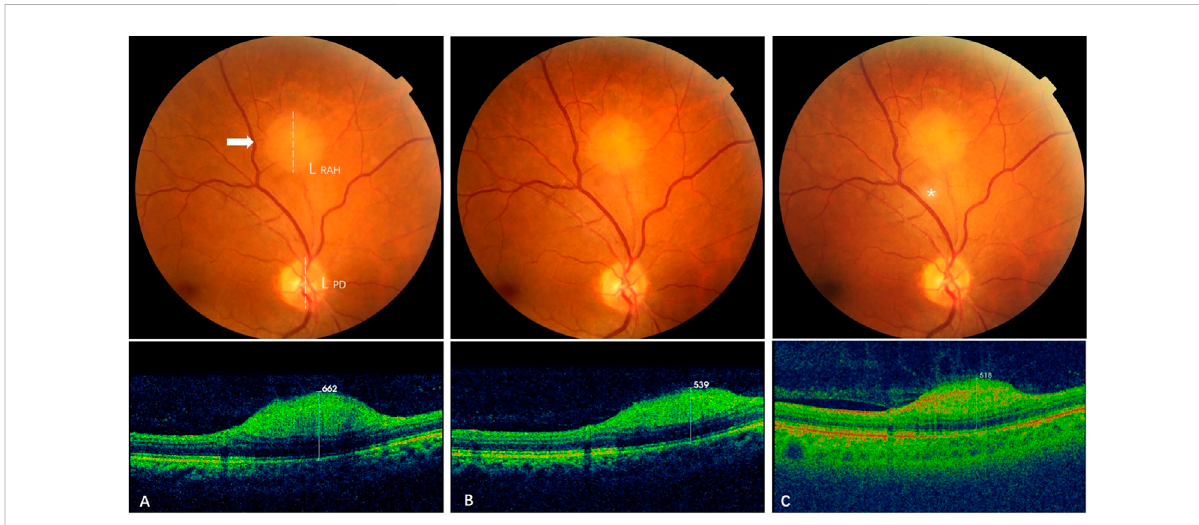
FIGURE 3 Effectofsirolimusontype1retinalastrocytichamartomaovertime. (A) Atbaseline,agray-whitetype1RAHlesion(arrow)located2DDsuperior to the optic disc of the right eye was measured with a maximal thickness (MT) of 662 μ m by spectral-domain optical coherence tomography (SD- OCT)andalongestbasediameter (LBD)of1.27DDbycalculatingtheratio oftheRAHLBDlength (L RAH, dashedline)tothevertical lengthofthedisc (L PD , dashed line) on color fundus photography. (B) At 12-month follow-up (short-term), MT of theRAH decreased to 539 μ m on SD-OCT, and LBDwas1.21DD,withaslightreductionfrombaselineLBD. (C) At28-monthfollow-up(long-term),thelastvisit,MToftheRAHfurtherdecreasedto 518 μ m on swept-source optical coherence tomography (SS-OCT), while the LBD remained stable at 1.22DD. The gray-white speckle (asterisk) in the center is an image artifact.